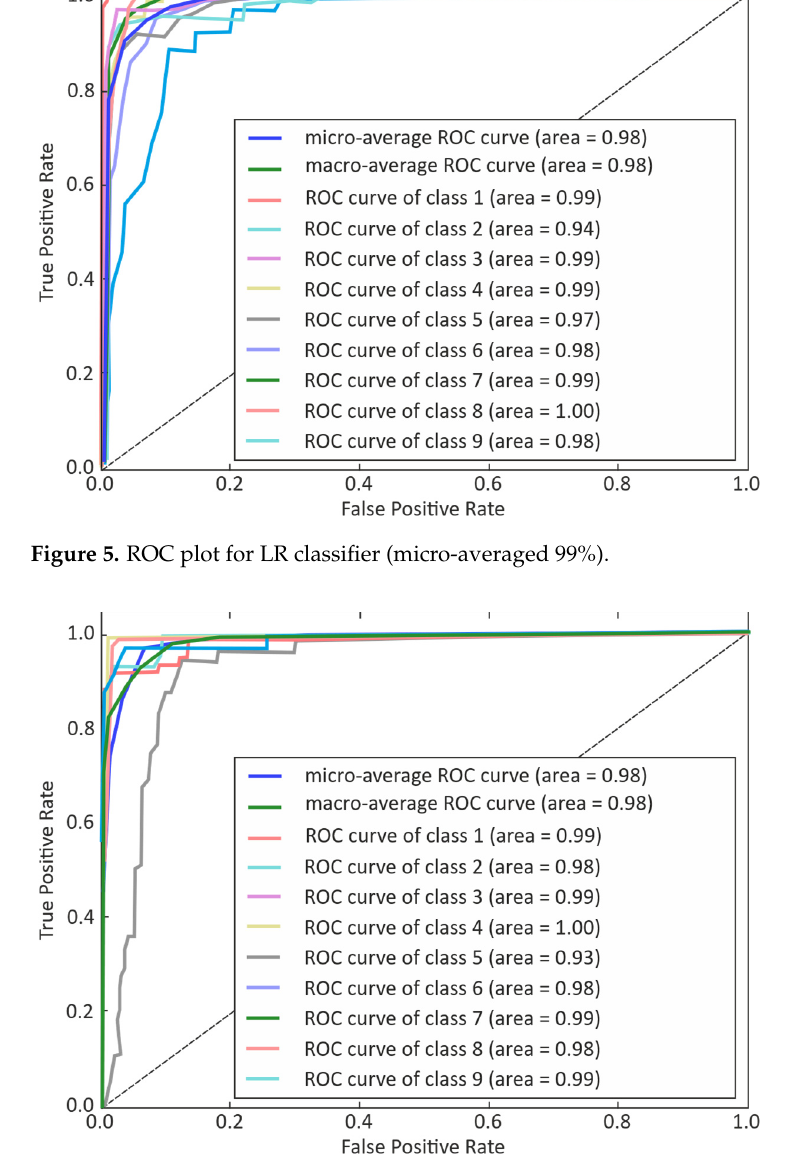
Figure 6. ROC plot for Gaussian NB classifier (micro-averaged 98%).